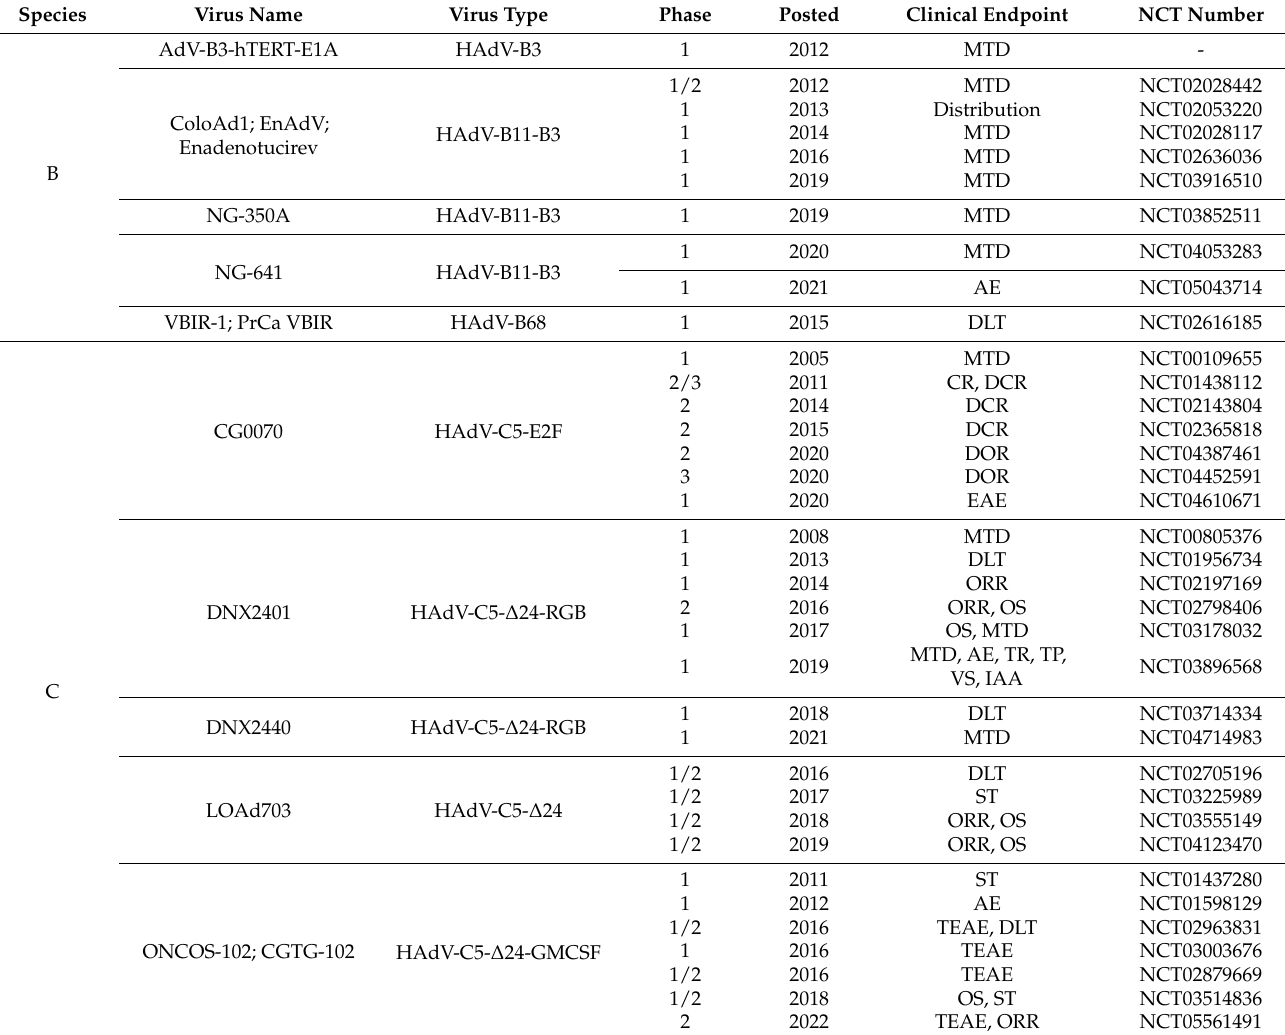
Table 1. Oncolytic adenovirus clinical